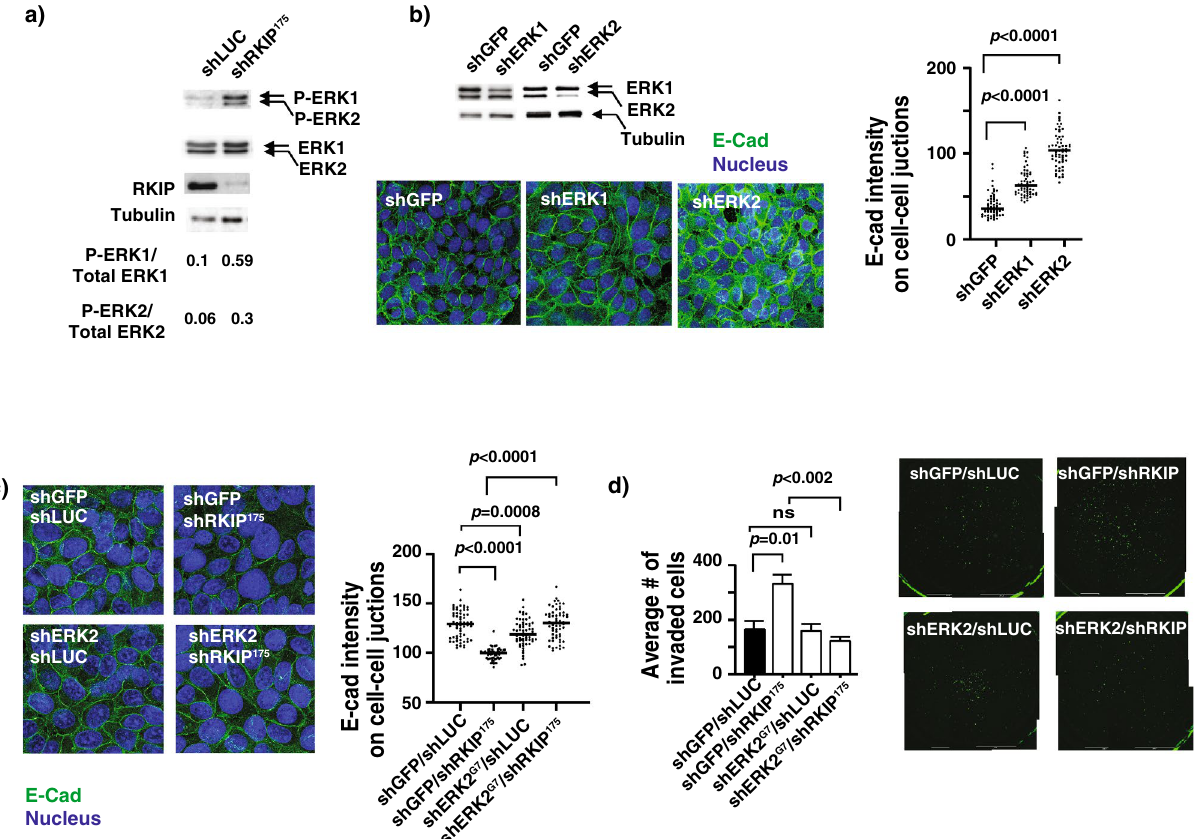
Figure 4. RKIP regulates E-cadherin (E-cad) and subsequent cell invasion through ERK2. ( a ) Representative western blots with lysates prepared from control knockdown (shLUC) or RKIP knockdown (shRKIP) BT20 as indicated. Numbers are shown for quantified phosphorylated ERK1 or ERK2 bands normalized with total ERK protein. ( b ) (Top left panel) Representative western blots of lysates prepared from control knockdown (shGFP), ERK1 (shERK1) or ERK2 (shERK2) BT20 cells. (Bottom left panel) Representative images of immunofluorescent staining with E-cad Ab and DRAQ5 of the same set of BT20 cells shown in the left top panel. (Right panel) E-cad intensity quantification on cell–cell junctions of immunofluorescent images shown in the left bottom panels using MetaMorph analysis software. ( c ) (Left panel) Representative images of immunofluorescent staining with E-cad Ab and DRAQ5 of BT20 cells with different combinations of control knockdown, RKIP knockdown (shRKIP) or ERK2 knockdown (shERK2). right) E-cad intensity quantification on cell–cell junctions of immunofluorescent images shown in the left bottom panels using MetaMorph analysis software. ( d ) (Left panel) Representative results of invasion assays with same set of cells used in ( c ) showing number of invaded cells through Matrigel in each indicated BT20 cell lines (mean ± SE). (Right panel) Representative images of the stained invaded cells in indicated cell lines shown at the left panel. Unpaired Student’s t-test (two-tailed) was used for all analyses with p < 0.05 considered significant. ns not